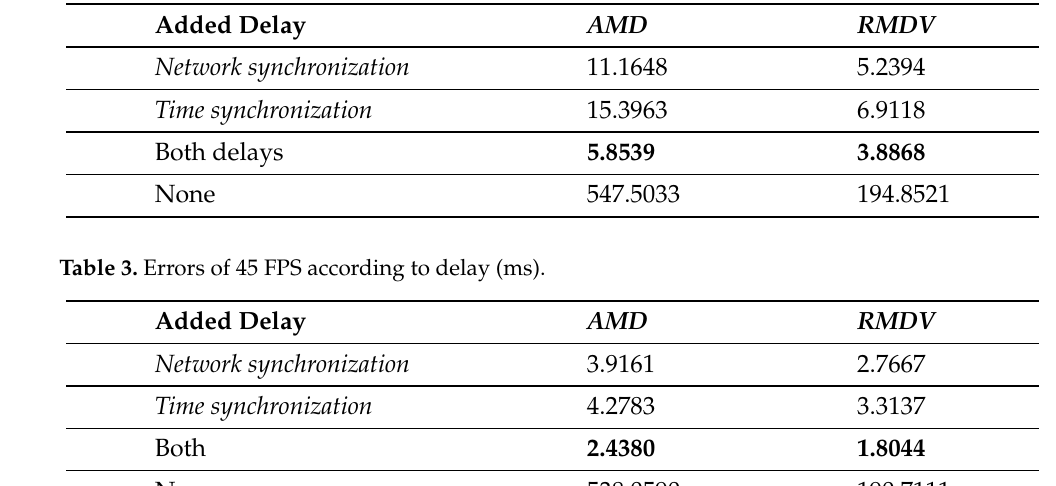
Table 2. Errors of 15 FPS according to delay (ms).